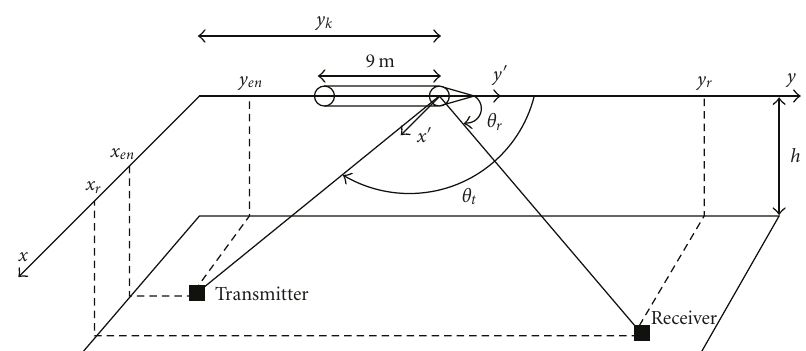
Figure 7: Targets “cycone” (a) and airplane (b).